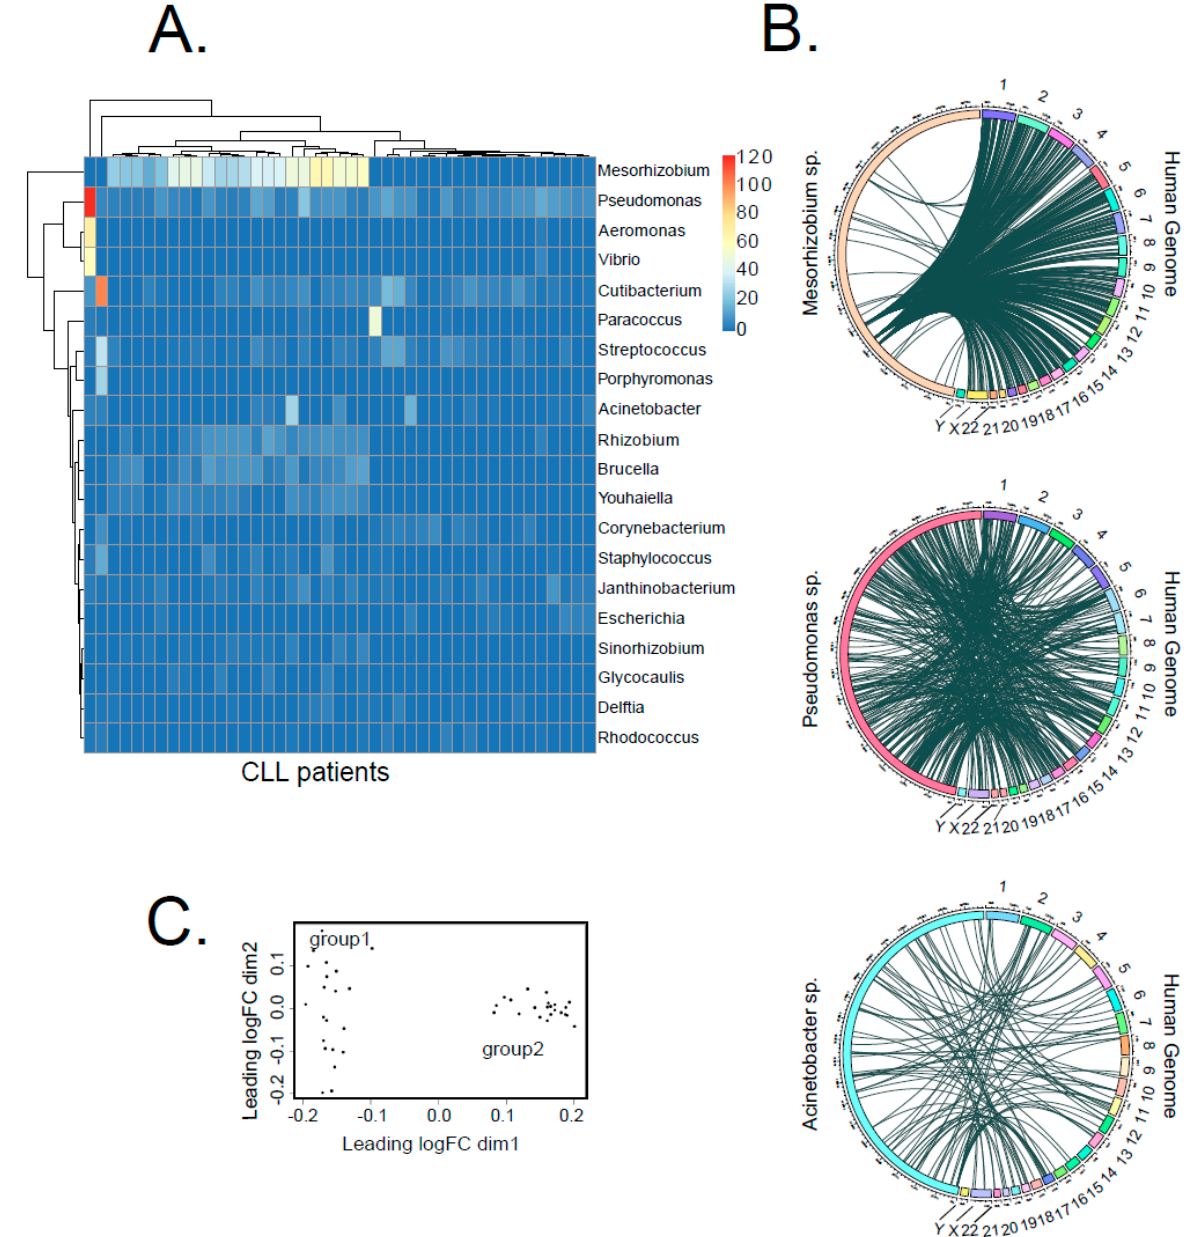
Figure 4. Distribution of bacterial species contributing to LGT in CLL. ( A ) The heat map shows the number of bacterial transcripts integrated into human genome from the 20 most abundant bacteria genera for each CLL sample. In total, we detected 216 different bacteria genera across the entire dataset. ( B ) Circos plots illustrate the integration sites of three selected bacteria genera ( Pseudomonas sp., Mesorhizobium sp. and Acinetobacter sp.) into the human genome. ( C ) MDS analysis of LGT event counts, using a matrix that lists the number of LGT events for each bacteria genus per patient.